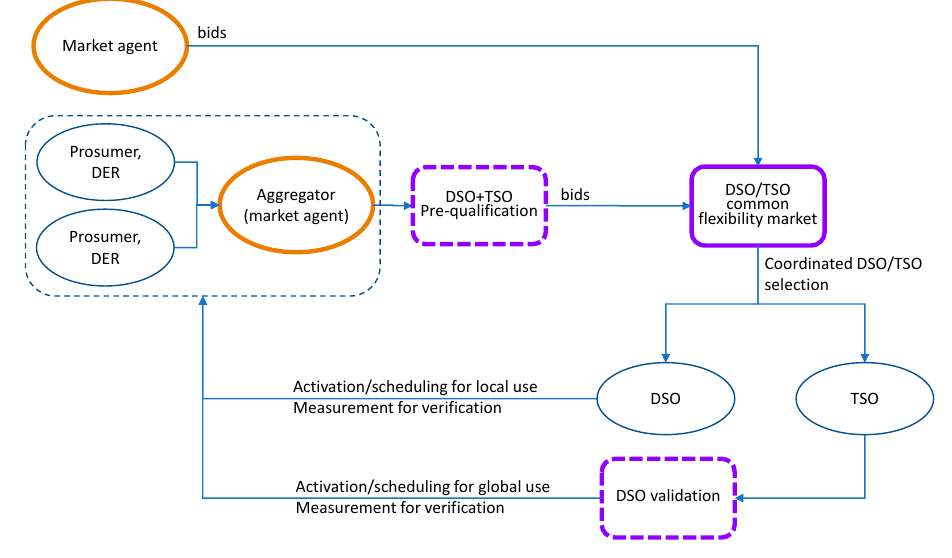
Figure 5. Common TSO-DSO flexibility market (M4).